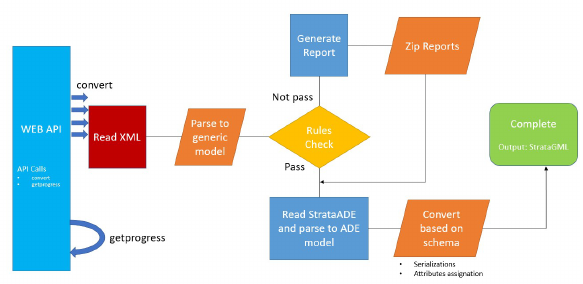
Figure 4 . The conversion process through Web API.